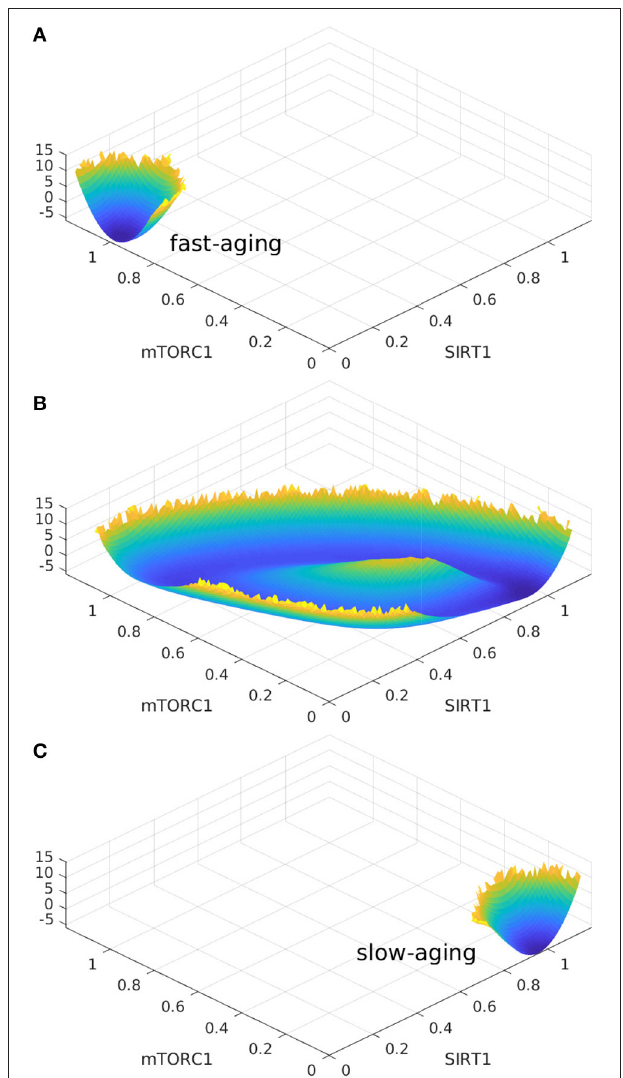
FIGURE 7 | The landscape topography changes from the monostable state of fast-aging to the oscillation between the fast-aging and the slow-aging, and then to the monostable slow-aging state upon the increase of the regulation of Sestrins- > AMPK. (A) The landscape of fast-aging. (B) The landscape of oscillation between fast-aging and slow-aging. (C) The landscape of